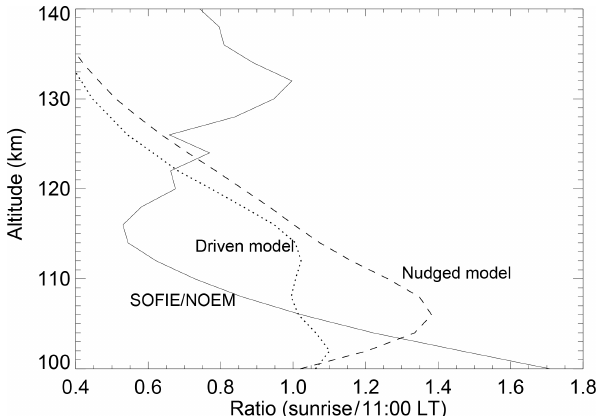
Figure 5. Monthly averaged atomic oxygen profiles from three sim- ulations with the TIME-GCM and two versions of the SABER database. The curve labeled old sab is the Version 2 data of Mlynczak et al. (2013); the curve labeled new sab is the reprocessed data described by Mlynczak et al.